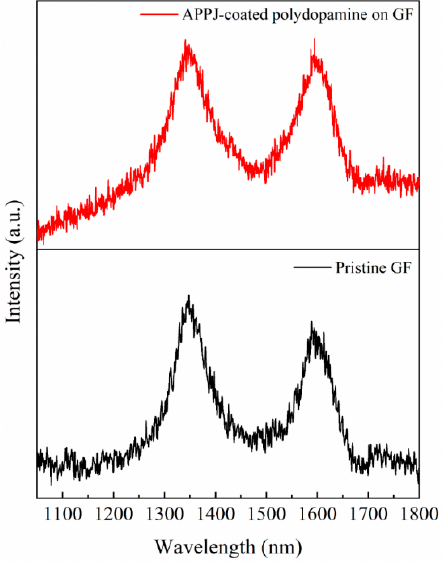
Figure 5. Raman spectrum of pristine GF and APPJ-coated polydopamine on GF.